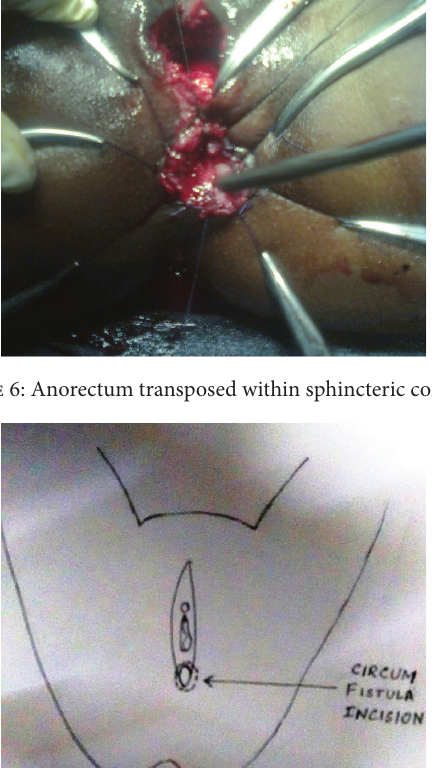
Figure 10: Incision made at proposed new anal opening.